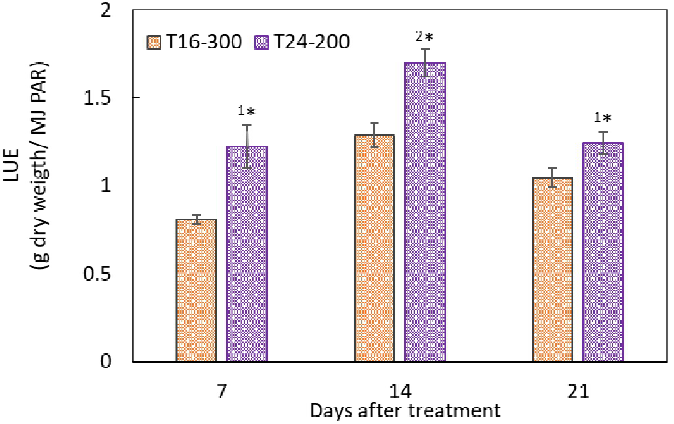
Figure 3. Light use efficiencies (LUE) in the leaf dry masses of nasturtium grown under T16-300 and T24-200 measured at 7, 14, and 21 days after treatment. Values are the means ± SE ( n = 6). The asterisk sign indicates significant differences between the treatments ( 1 *, p < 0.05 and 2 *, p < 0.01), determined by the t -test.